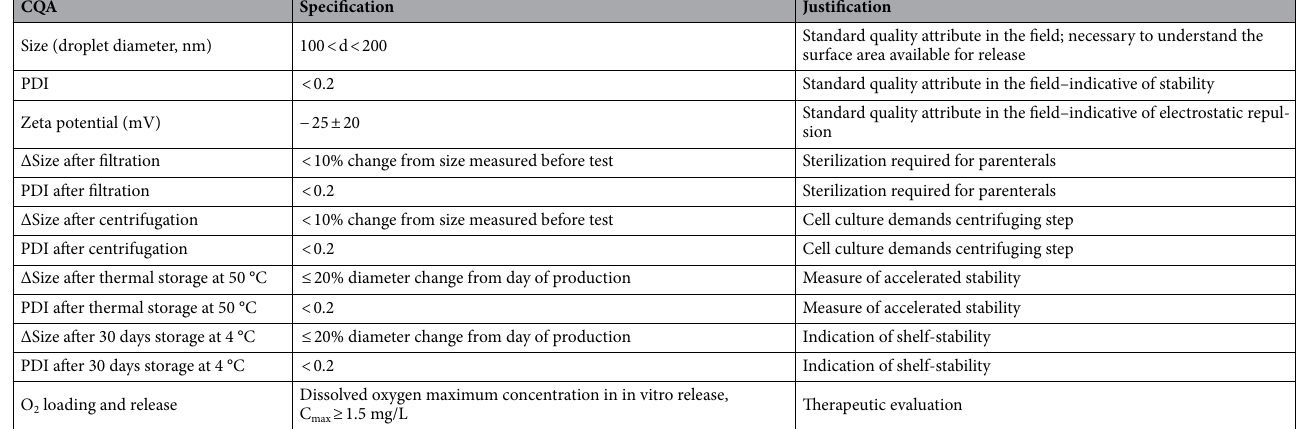
Table 1. Critical quality attributes (CQAs) for the reported perfluorocarbon nanoemulsions, specifications, and justifications. PDI polydispersity index, d diameter, mV millivolt, nm